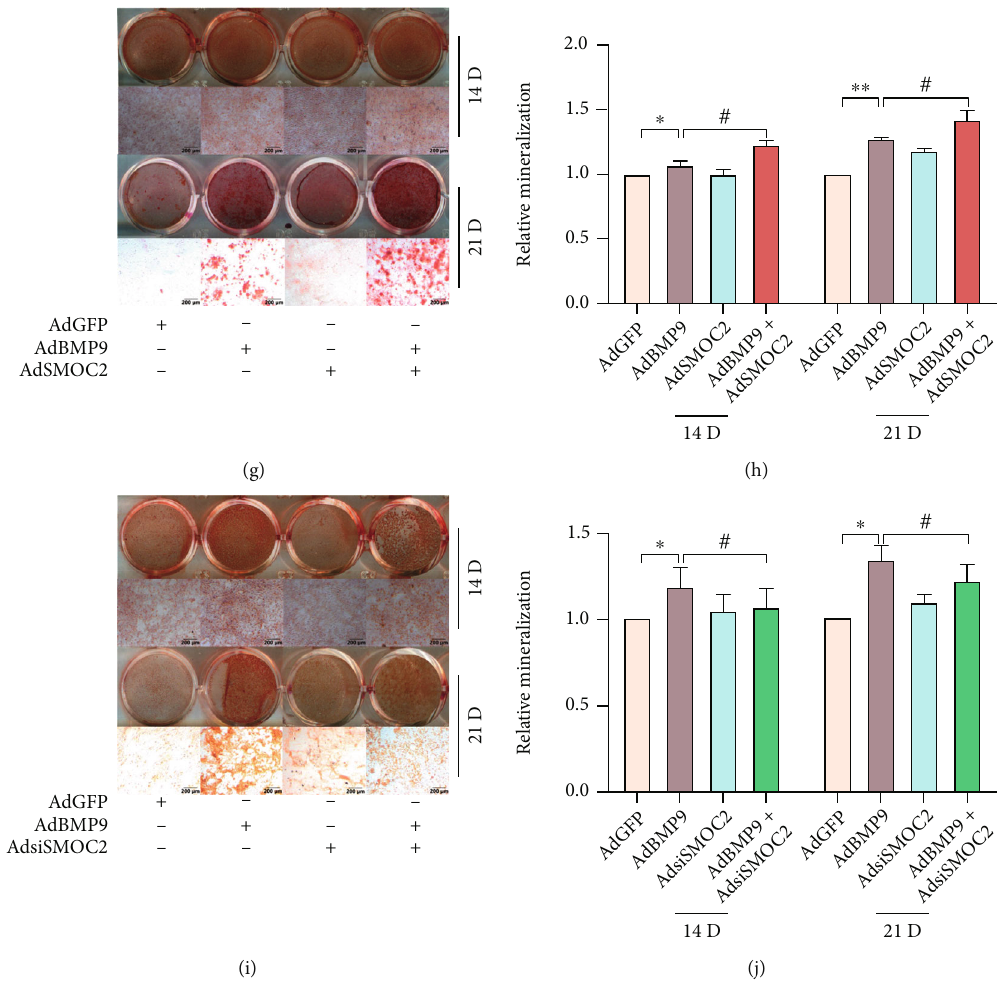
Figure 3: Exogenous SMOC2 expression enhances BMP-9-induced late osteogenic marker expression and matrix mineralization. (a) Real- time PCR assay results showed the e ff ect of SMOC2 on the mRNA expression of OPN promoted by BMP9 in MEFs. (b) Western blot assay results showed the e ff ect of SMOC2 on the protein expression of OPN promoted by BMP9 in MEFs. (c) Quanti fi cation of the western blot results showed the e ff ect of SMOC2 on OPN protein expression promoted by BMP9 in MEFs. (d) Real-time PCR assay results showed the e ff ect of SMOC2 knockdown on the mRNA expression of OPN promoted by BMP9 in MEFs. (e) Western blotting assay results showed the e ff ect of SMOC2 knockdown on OPN protein expression induced by BMP9 in MEFs. (f) Quanti fi cation of the western blot results showed the e ff ect of SMOC2 on OPN protein expression promoted by BMP9 in MEFs. (g) Alizarin Red S staining results showed the e ff ect of SMOC2 on BMP9-induced mineralization in MEFs. (h) Quanti fi cation results of Alizarin Red S staining showed the e ff ect of SMOC2 on BMP9-induced mineralization in MEFs. (i) Alizarin Red S staining results showed the e ff ect of SMOC2 knockdown on BMP9-induced mineralization in MEFs. (j) Quanti fi cation results of Alizarin Red S staining showed the e ff ect of SMOC2 knockdown on BMP9-induced mineralization in MEFs. Compared with the control group, ∗ p < 0 : 05 ; ∗ ∗ p < 0 : 01 ; compared with the AdBMP9 group, # p < 0 : 05 , ## p < 0 : 01